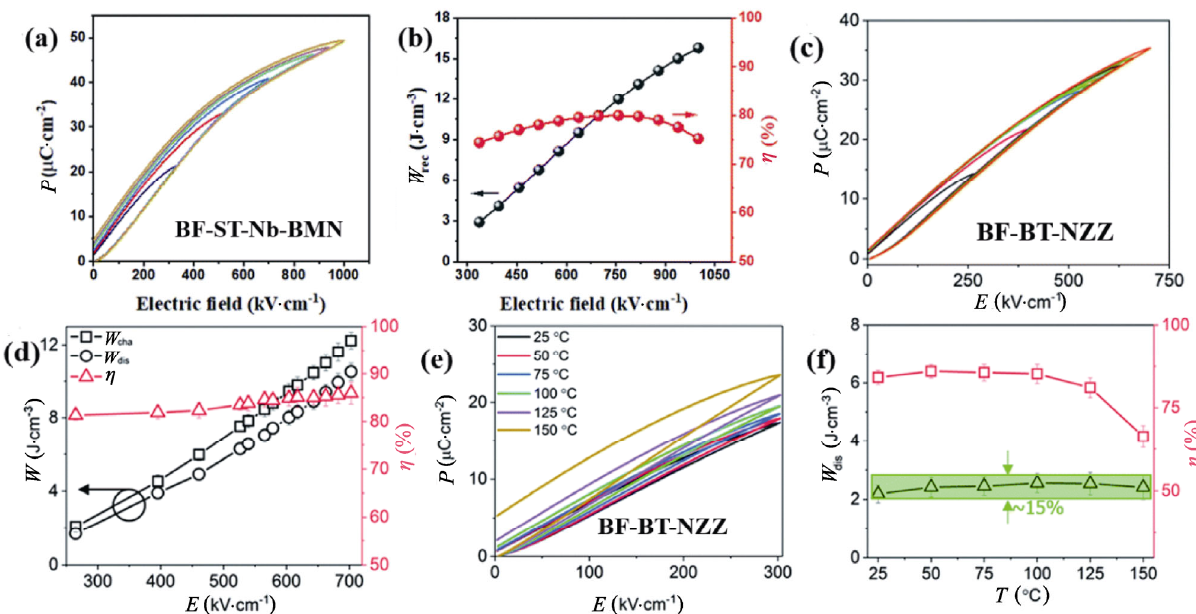
Fig. 31 (a) P–E loops and (b) energy-storage performance of the BF–ST–Nb–BMN MLCCs at room temperature. (c) P–E loops and (d) energy-storage performance of the BF–BT–NZZ MLCCs at room temperature. (e) P–E loops and (f) energy-storage performance of BF–BT–NZZ MLCCs at various temperatures. Reproduced with permission from Ref. [137],